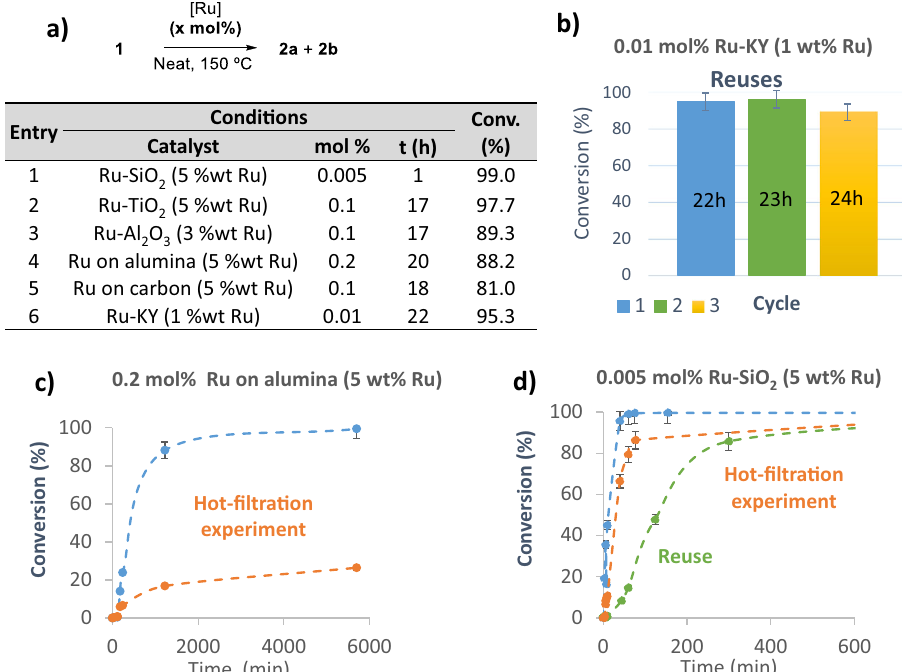
Fig. 4 Supported Ru catalysts, reuse and leaching tests. a Results for the isomerization of 1 with different Ru – supported solid catalysts. Ru – KY refers to zeolite NaY exchanged with K + and then with Ru 3 + . The Ru wt% on each solid is indicated between brackets, mol% refers to the catalytic amount of Ru in reaction. b Reuses of Ru – KY. c Hot fi ltration leaching test for commercial Ru – Al 2 O 3 . d Hot fi ltration leaching test and reuse of Ru – SiO 2. The supported Ru catalysts are either commercial (entry 4 and 5) or in – house prepared by impregnation of aqueous RuCl 3 (entry 1 – 3 and 6). The optimized amount of catalyst is shown for each solid. Error bars account for a 5% uncertainty.